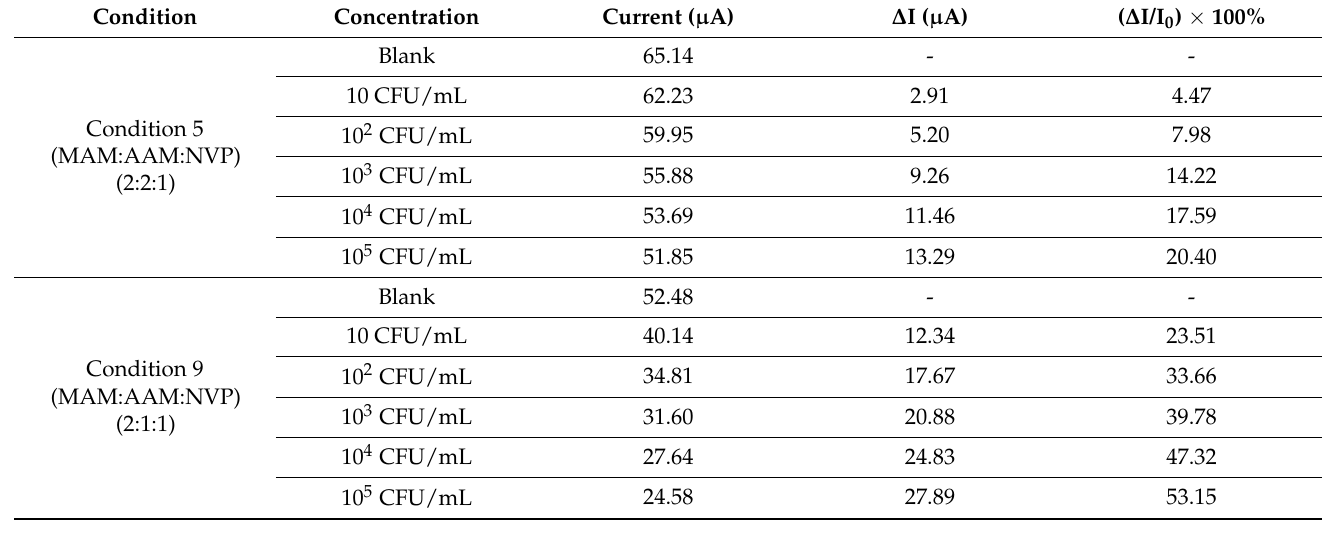
Table 4. The current data of conditions 5 and 9 on gold electrode.